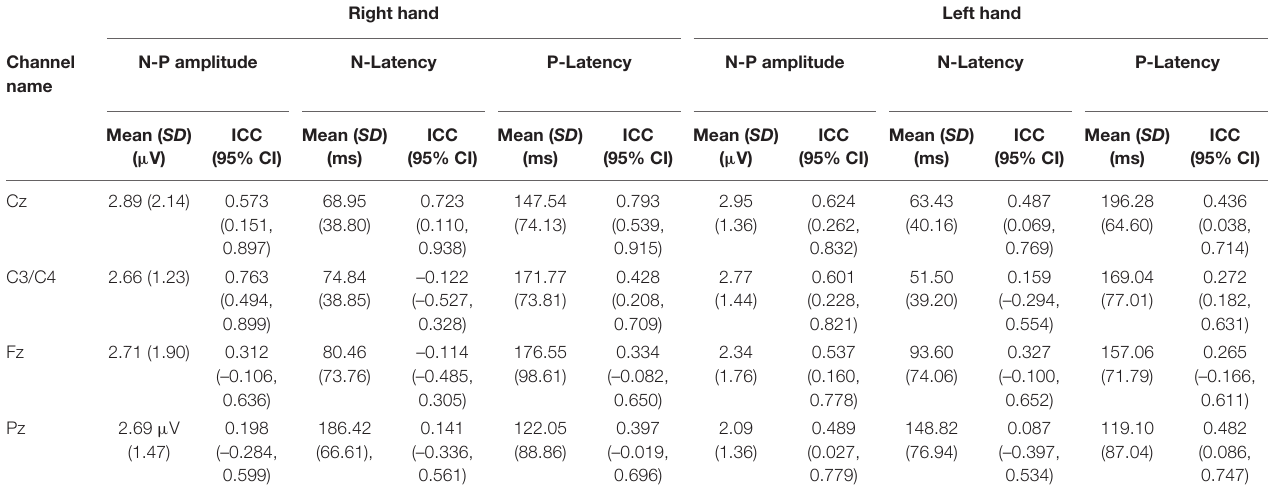
FIGURE 2 | Grand-averaged pin-prick evoked potential response at Cz, C3/C4, Fz, and Pz channels for right and left hand. Response in color red is depicted for session 1 and response in color blue is depicted for session 2. TABLE 1 | The mean N-P amplitude and latency with respective intraclass correlation coefficient values of the first peak of the PPEP at the Cz, C3/C4, Fz, and Pz channels. Right hand Left